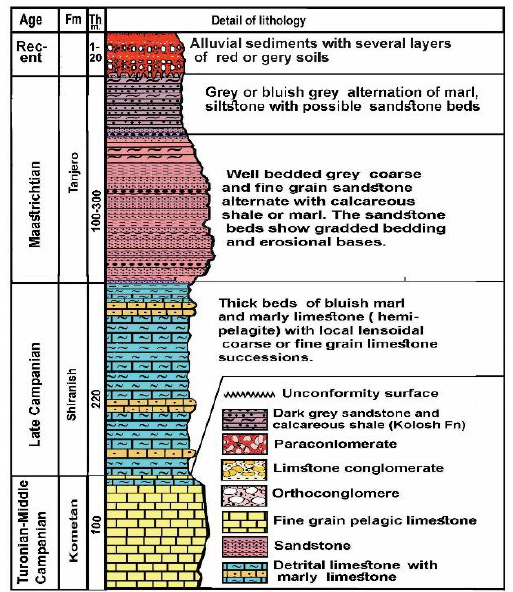
Figure 4. Stratigraphic column of the study area (based on [23]).